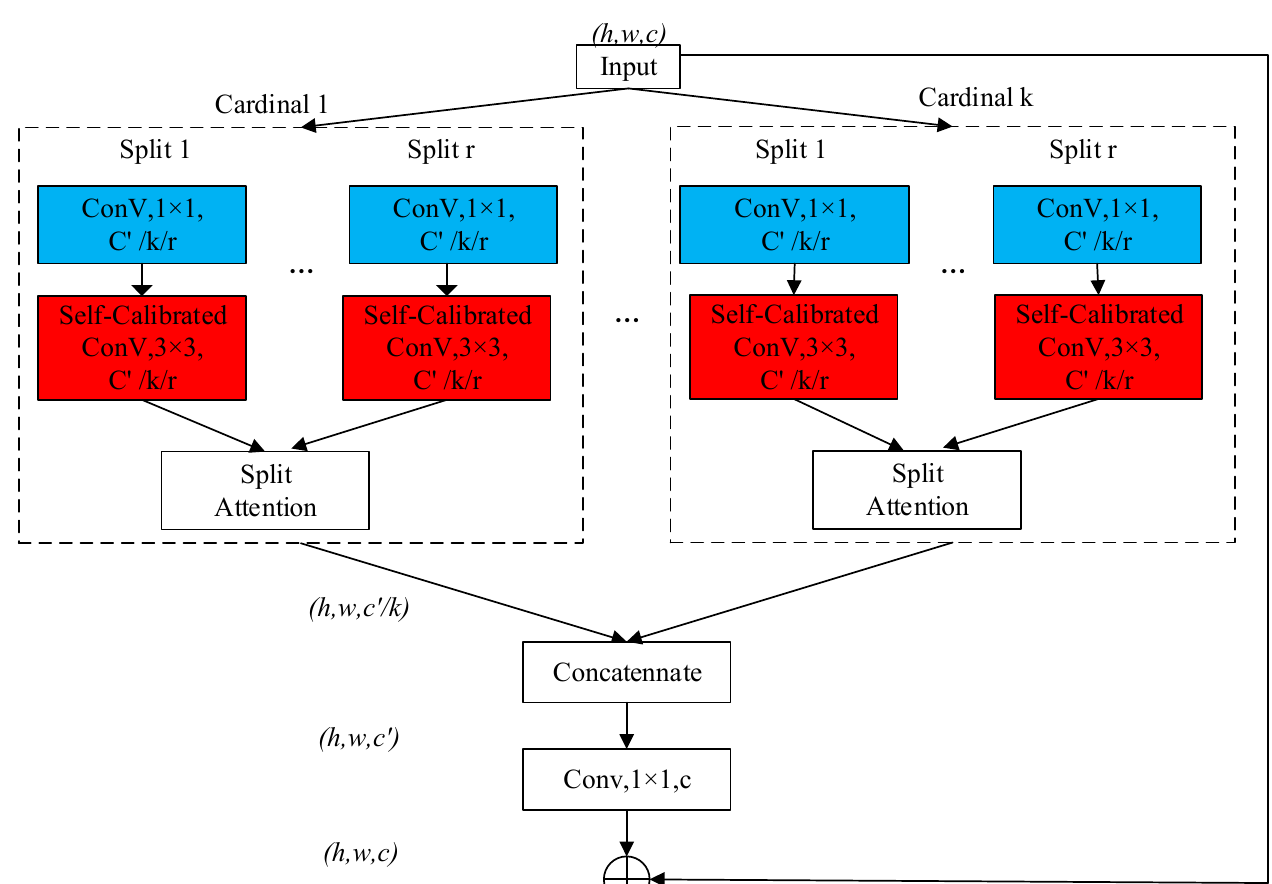
Figure 2. The SCNeSt block. The blue module represents vanilla convolutions, and the red module describes self-calibrated convolutions.